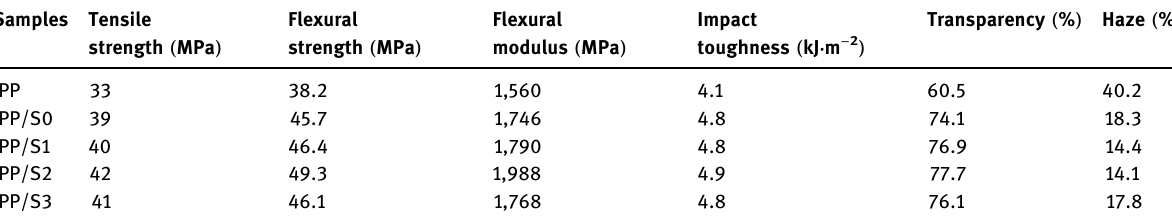
Table 5: Mechanical and optical properties of iPP composites Samples